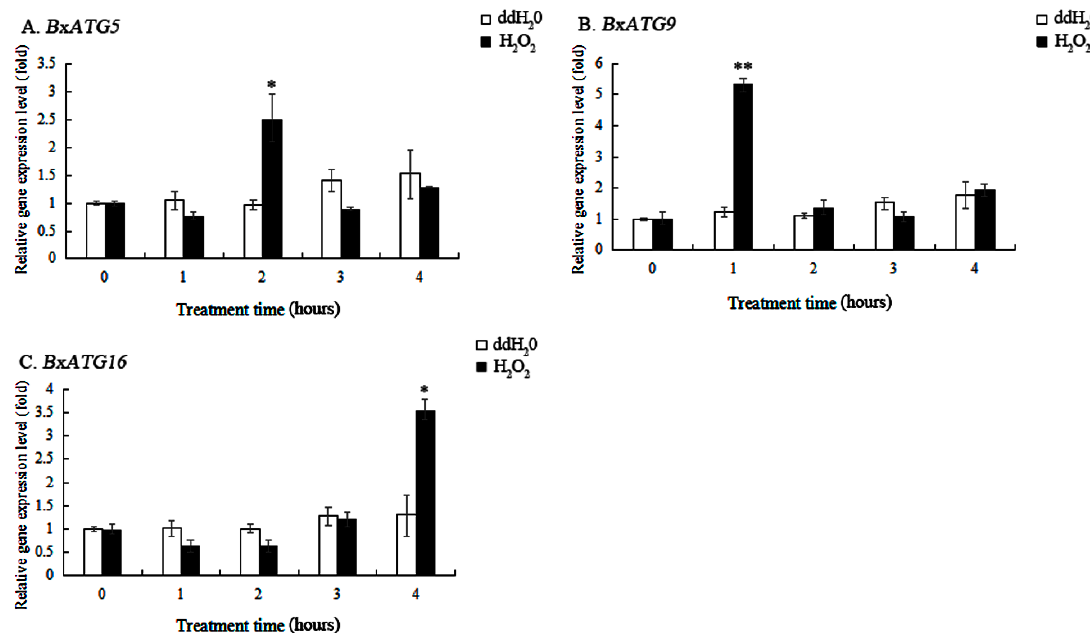
Figure 4. Relative expression levels of the autophagy genes BxATG5 , BxATG9 , and BxATG16 in PWN under H 2 O 2 stress. ddH 2 O was used as the control. ( A ) BxATG5 . ( B ) BxATG9 . ( C ) BxATG16 . Data are presented as the mean ± SD. * p < 0.05 and ** p < 0.01.